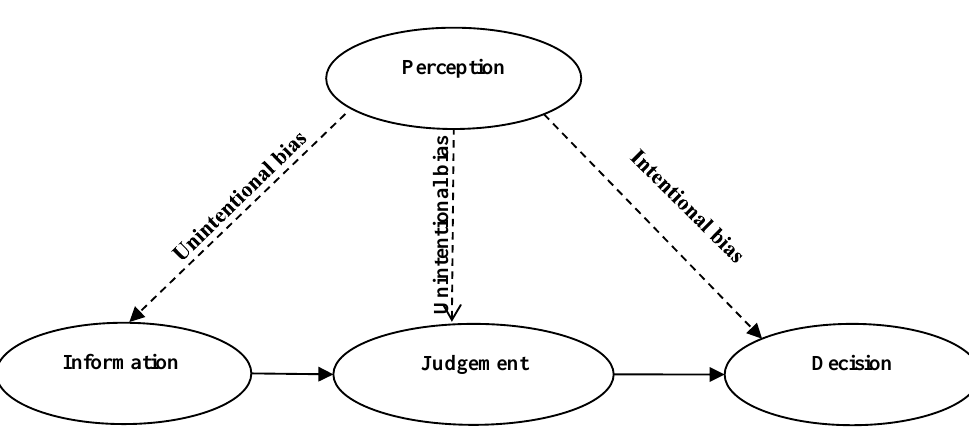
Figure 2. Decision-Marketing Capacity Model (Rodgers,